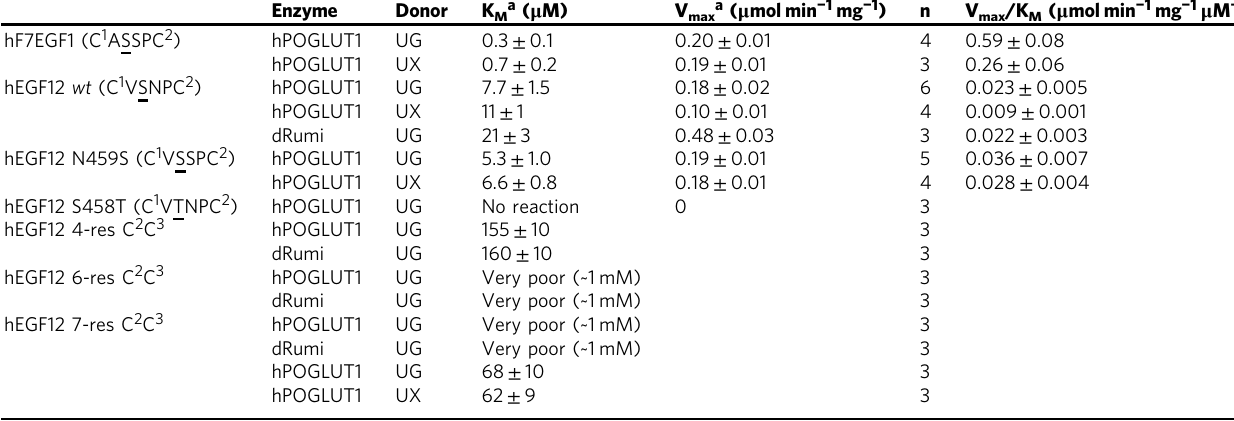
Table 1 Kinetic parameters of POGLUT1 and dRumi with EGF-like domains and UDP-glucose (UG) or UDP-xylose (UX)